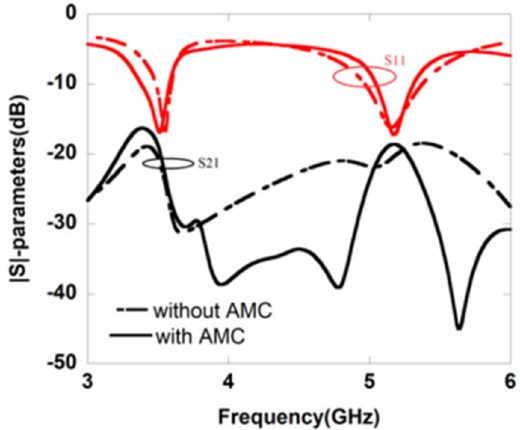
Figure 10. Prototype of CPW-fed MIMO design [47].